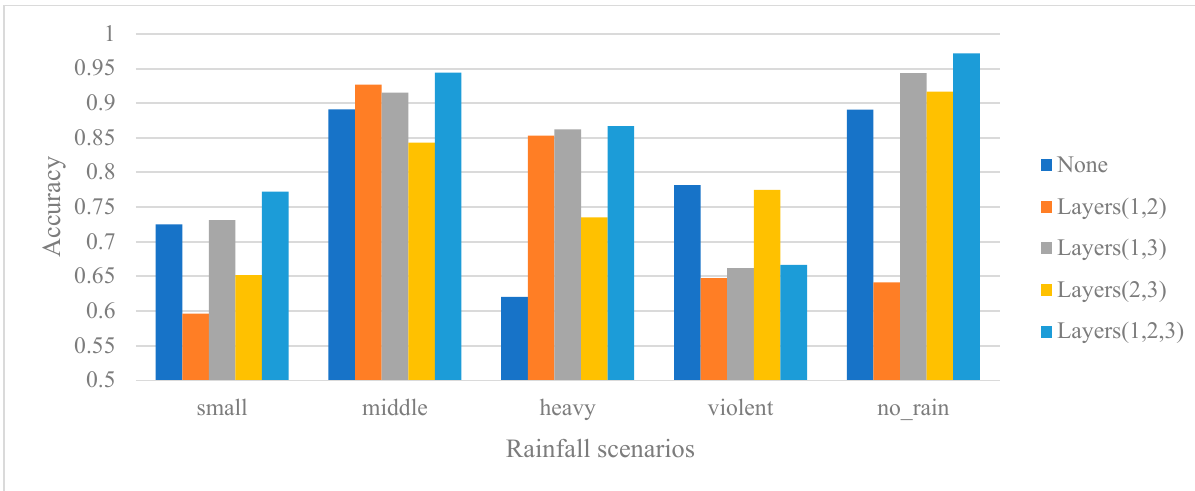
Figure 8. Comparison of accuracy for different multi-scale structures.